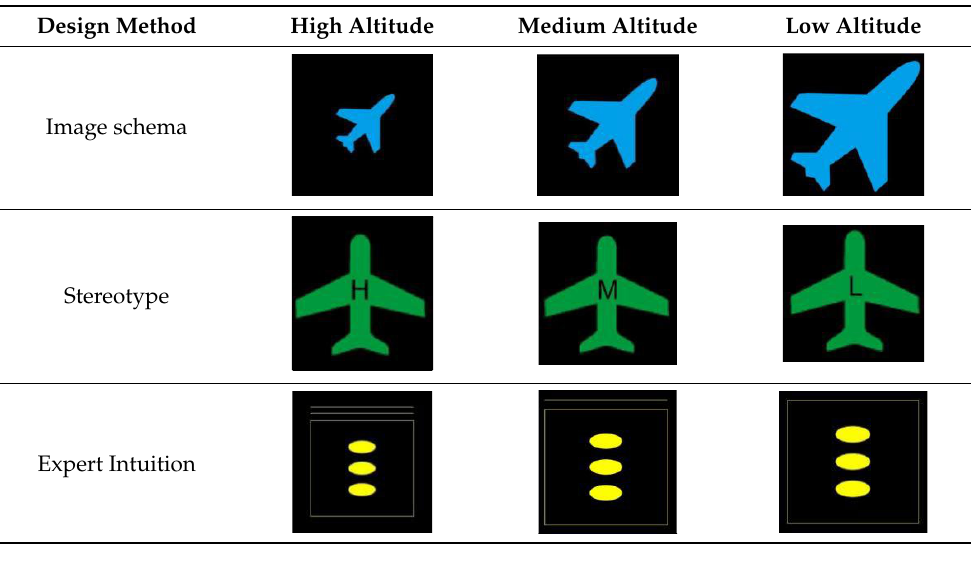
Table 4. Example of threat level display design.